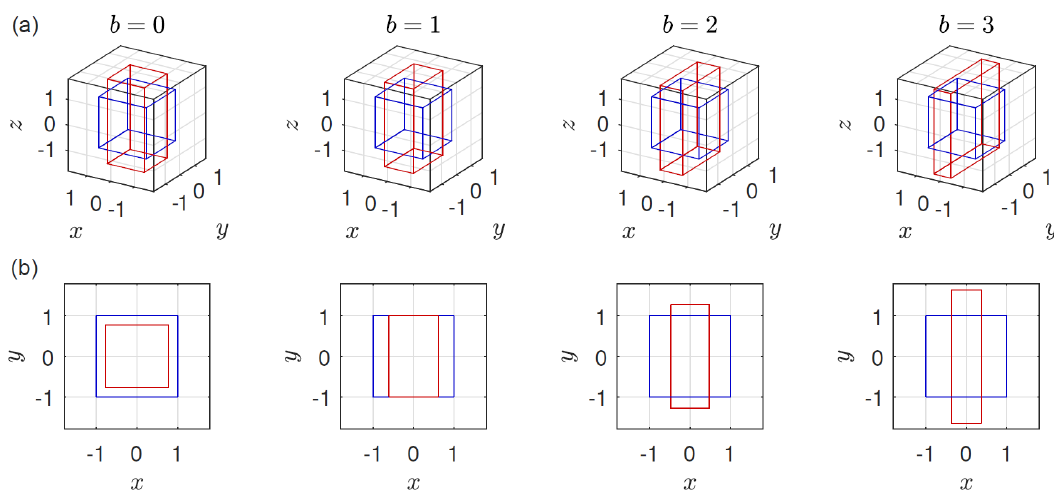
Figure 1. Prominent, qualitatively different examples for isochoric deformations r (cid:48) (red) of a unit cell r (blue) in shearfree flows: (i) uniaxial extension ( b = 0), (ii) planar extension ( b = 1), (iii) elliptical extension ( b = 2), and (iv) equibiaxial extension ( b = 3). For each scenario the situation is depicted